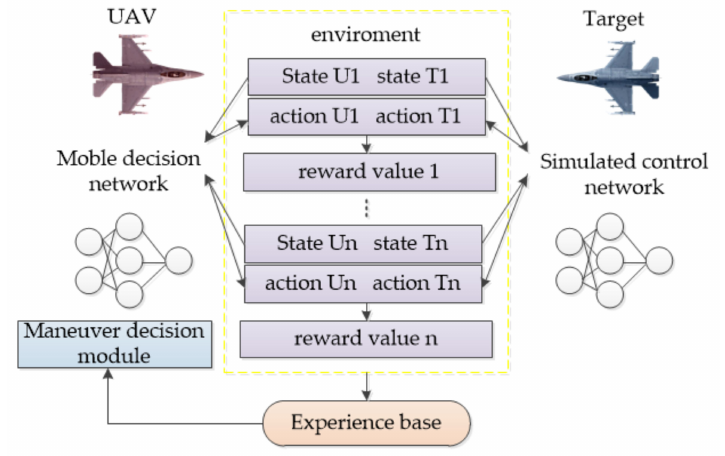
Figure 1. Air combat training